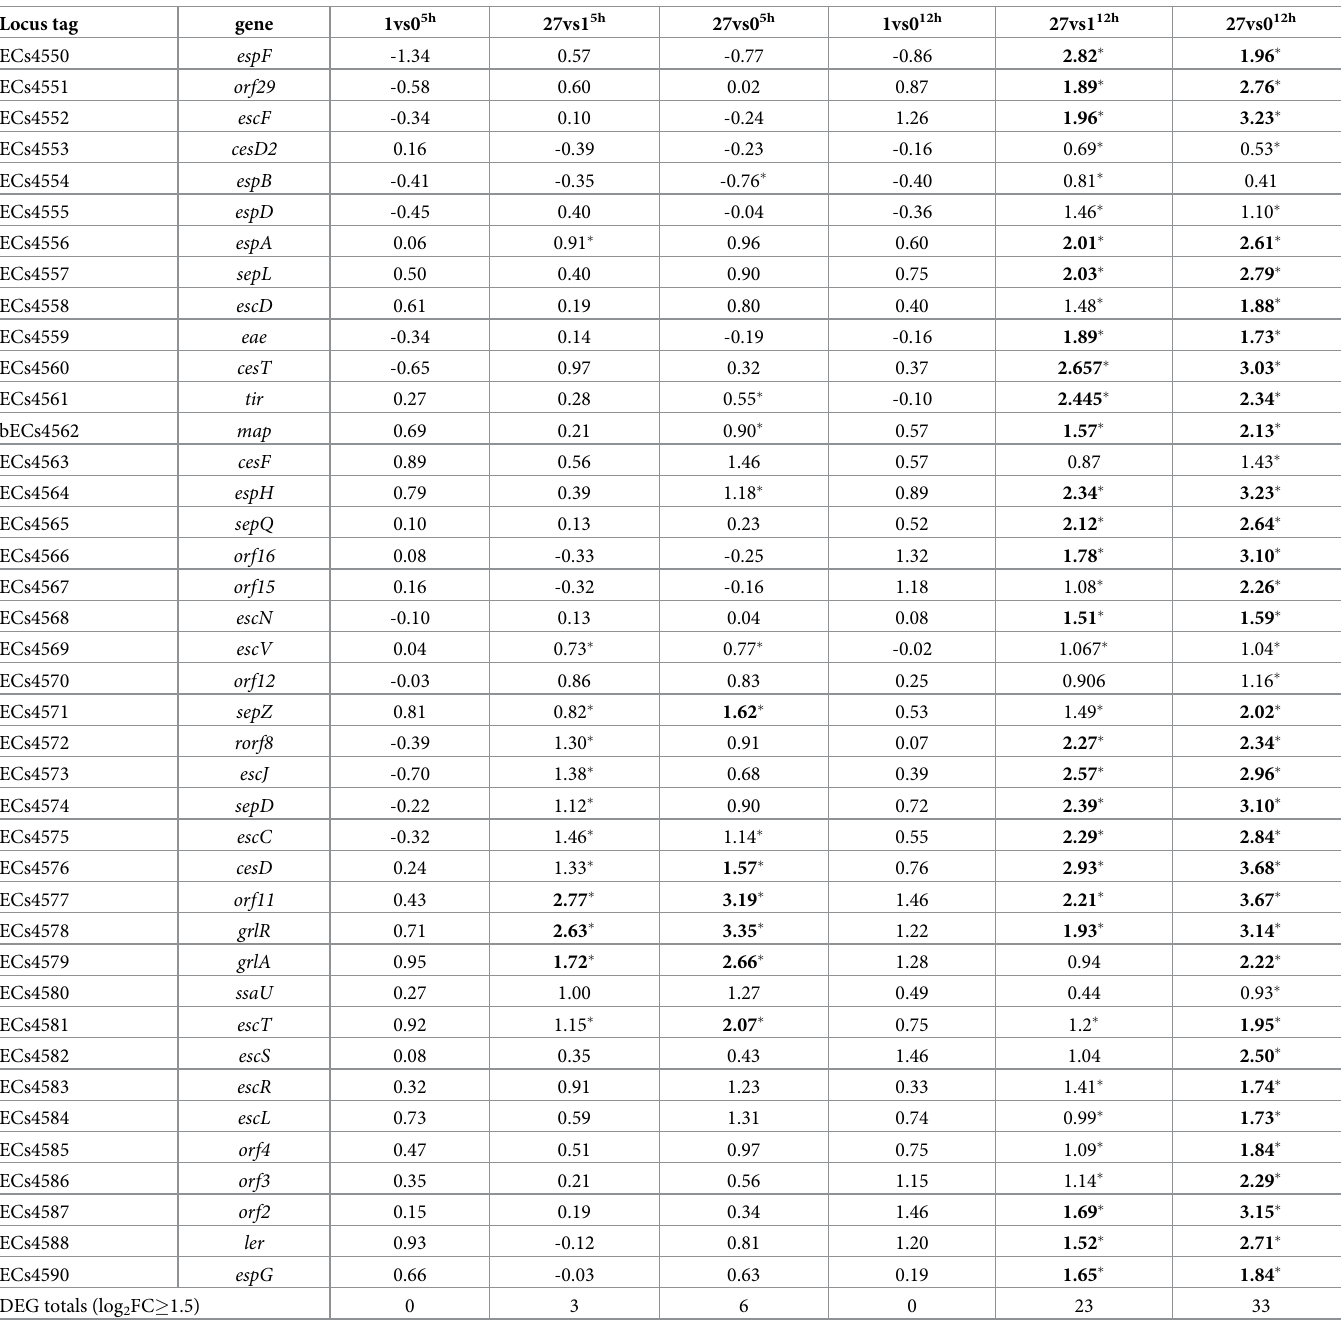
Table 4. Differential expression (log 2 FC) of LEE genes derived from RNA-Seq comparisons of serotype O157:H7 strain PA20 grown for five hours or 12 hours in LB-NS at 30˚C in the presence of different SMX-TM concentrations as shown. Comparisons with a log 2 FC (cid:21) 1.5 or (cid:20) -1.5 (FC (cid:21) 3) are shown in bold. Locus tag